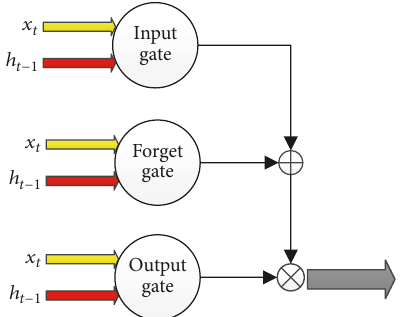
Figure 4: Architecture of the Long Short-Term Memory.